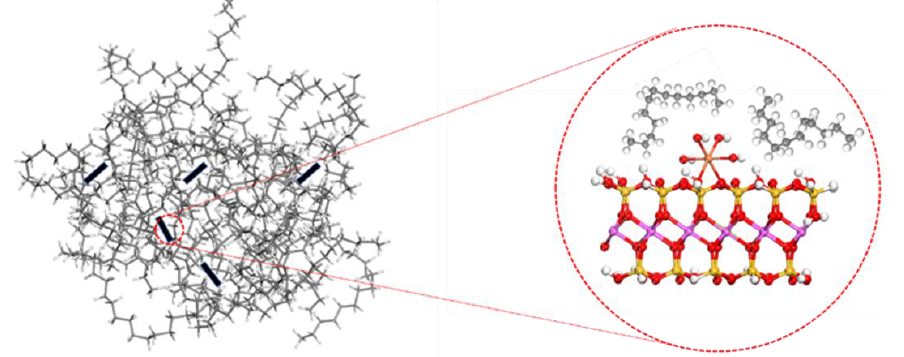
Figure 5. Fe-MMT distribution in masterbatch or film samples.